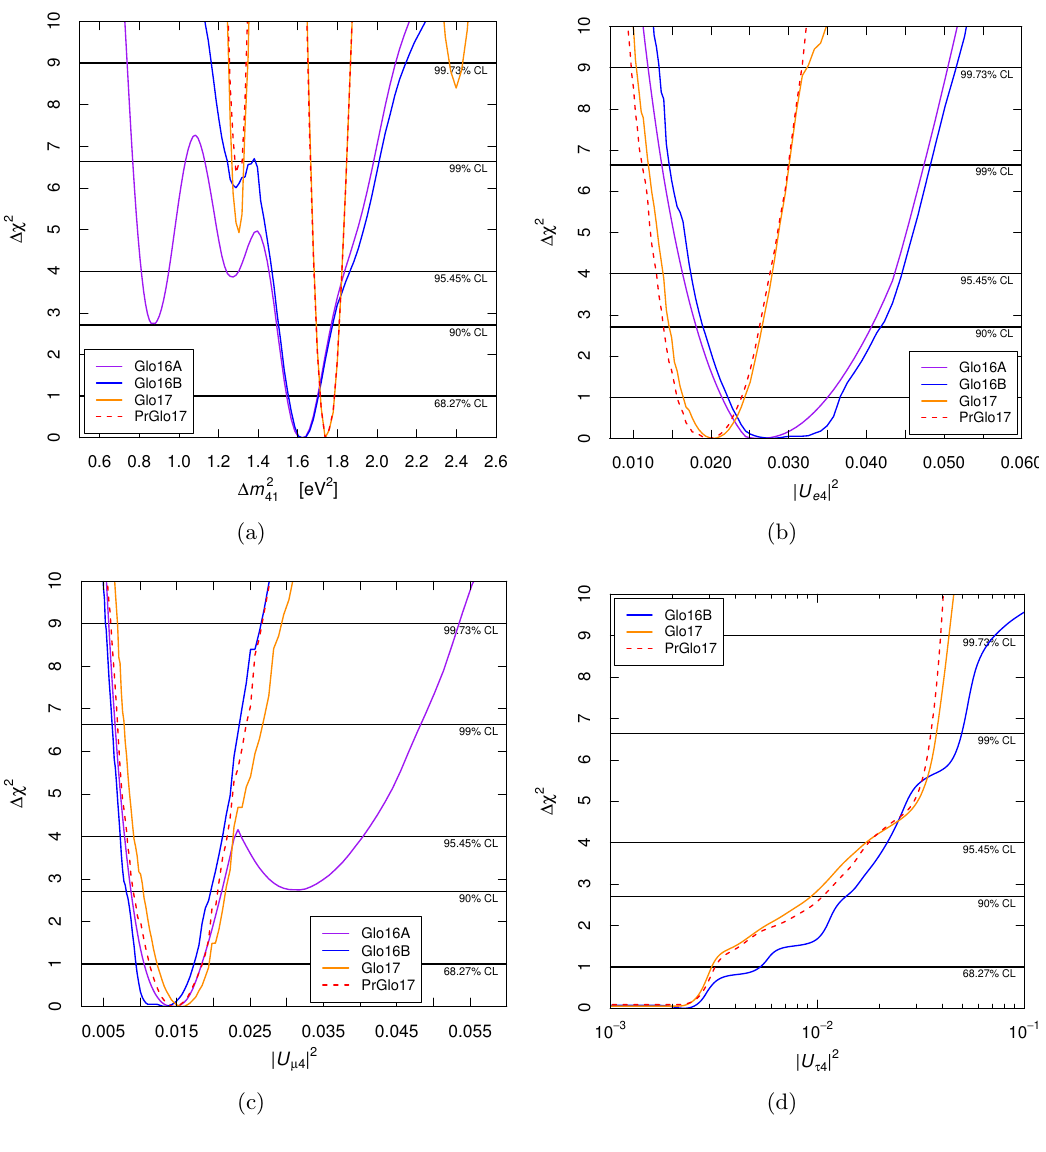
Figure 9 . Marginal (cid:1) (cid:31) 2 = (cid:31) 2 (cid:0) (cid:31) 2 (b), j U (cid:22) 4 j 2 (c), and j U (cid:28) 4 j 2 (d). The black horizontal lines show the (cid:1) (cid:31) 2 for one degree of freedom corresponding to the indicated con(cid:12)dence level